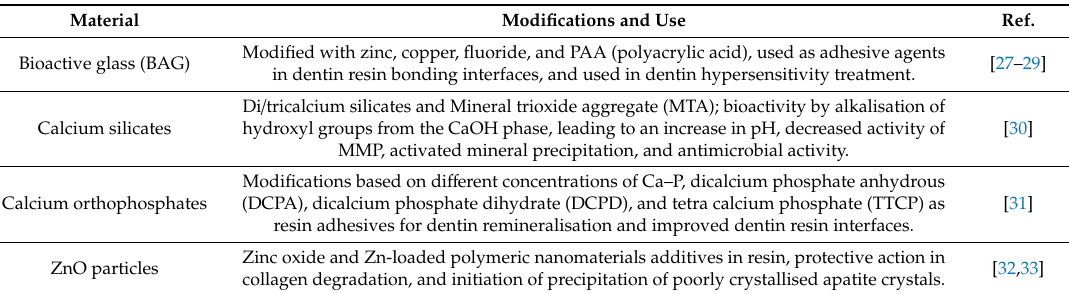
Table 1. Ion-release-based biomaterials for dentin